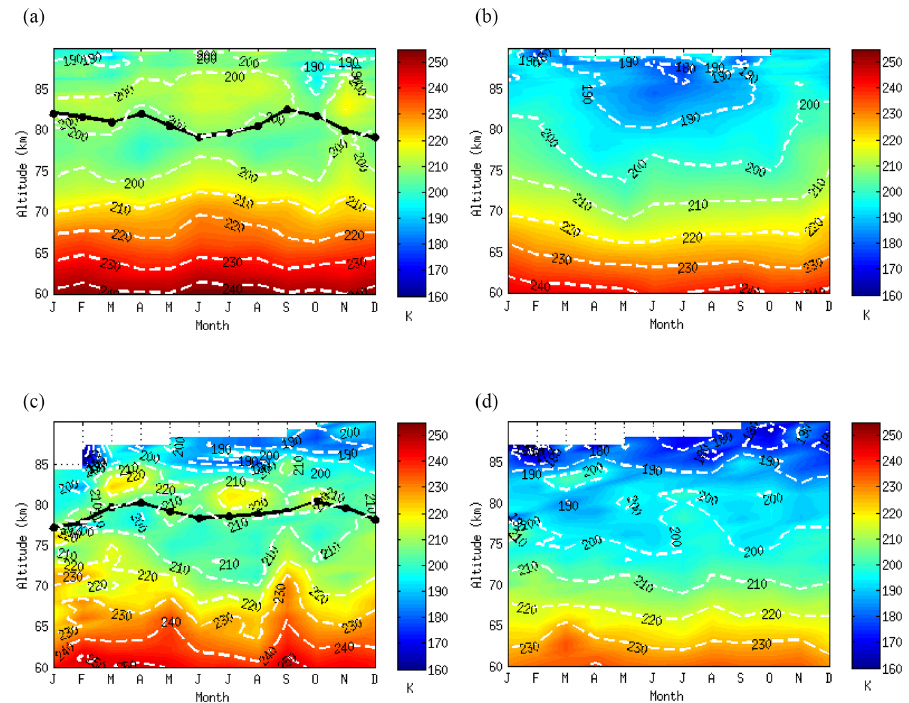
Figure 7. Mean monthly temperature profiles with (a, c) and without (b, d) inversion layer over Mauna Loa (a, b) and Réunion (c, d) during 1994–2014 and 1994–2009, respectively. The black line represents the mean base of the inversion